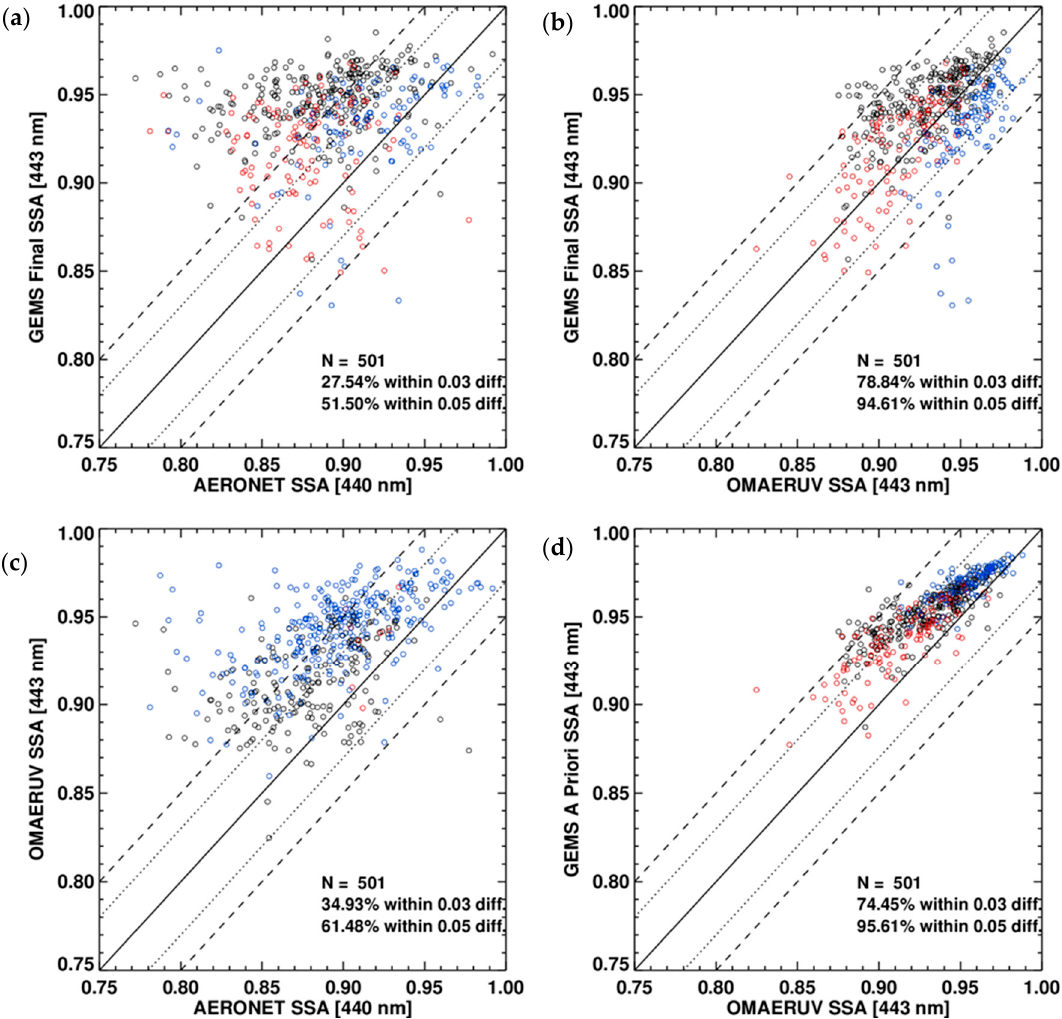
Figure 10. Comparison of ( a ) GEMS and AERONET SSA, ( b ) GEMS and OMAERUV SSA, ( c ) OMAERUV and AERONET SSA and ( d ) GEMS a priori and OMAERUV SSA (443 nm). Colors indicate the aerosol type distinguished by the satellite algorithm shown on the y -axis. Black: HAF (smoke for OMAERUV), red: dust and blue: NA. Dashed and dotted lines indicate an uncertainty envelope of ±0.05 and ±0.03 in SSA, respectively. Black solid lines are 1:1 lines.